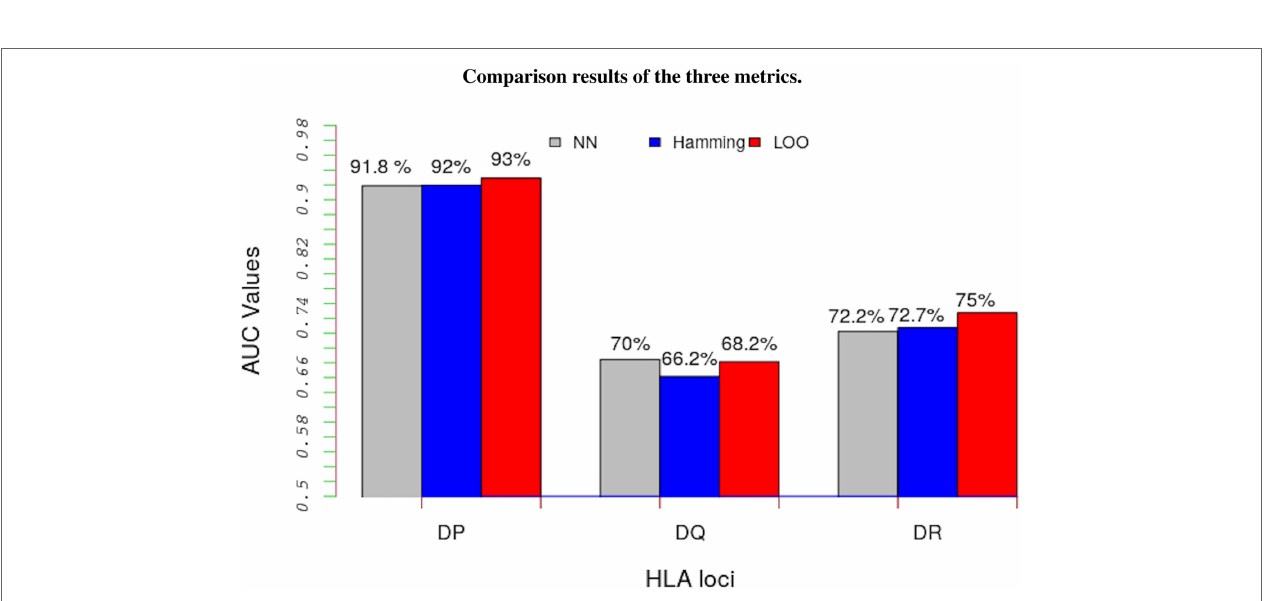
FIGURE 3 | Average performance results of the model in terms of AUC values for the three metrics: NN approach (gray bars), Hamming metric (blue bars), and the LOO method (red bars). Except for HLA-DQ loci, the LOO approach significantly out performs the other two metrics. Such results indicate that this method performs better than a random test even for un-characterized MHC-II molecules.